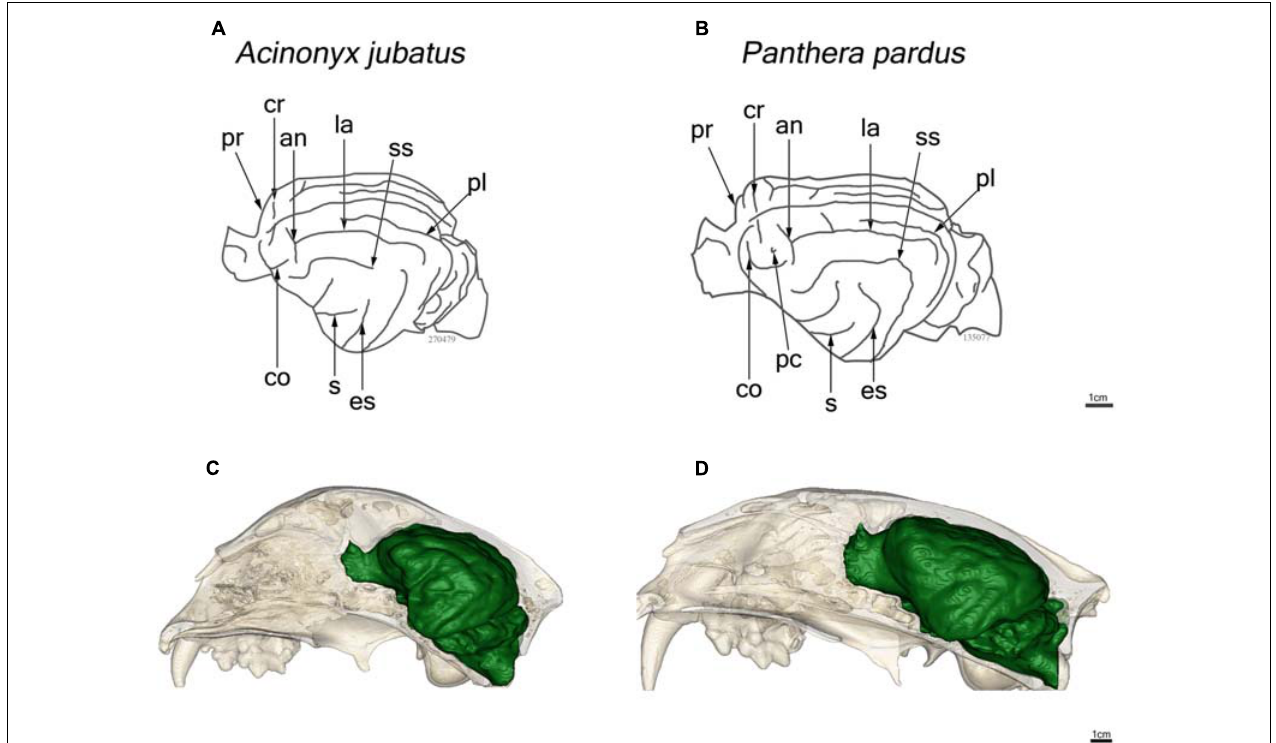
FIGURE 4 | Line drawings of a lateral view of the endocasts of the cheetah, Acinonyx jubatus (A) and leopard, Panthera pardus (B). Abbreviations as in Figure 1 . In situ reconstructions of the skull and endocast for each species are shown in (C) and (D)